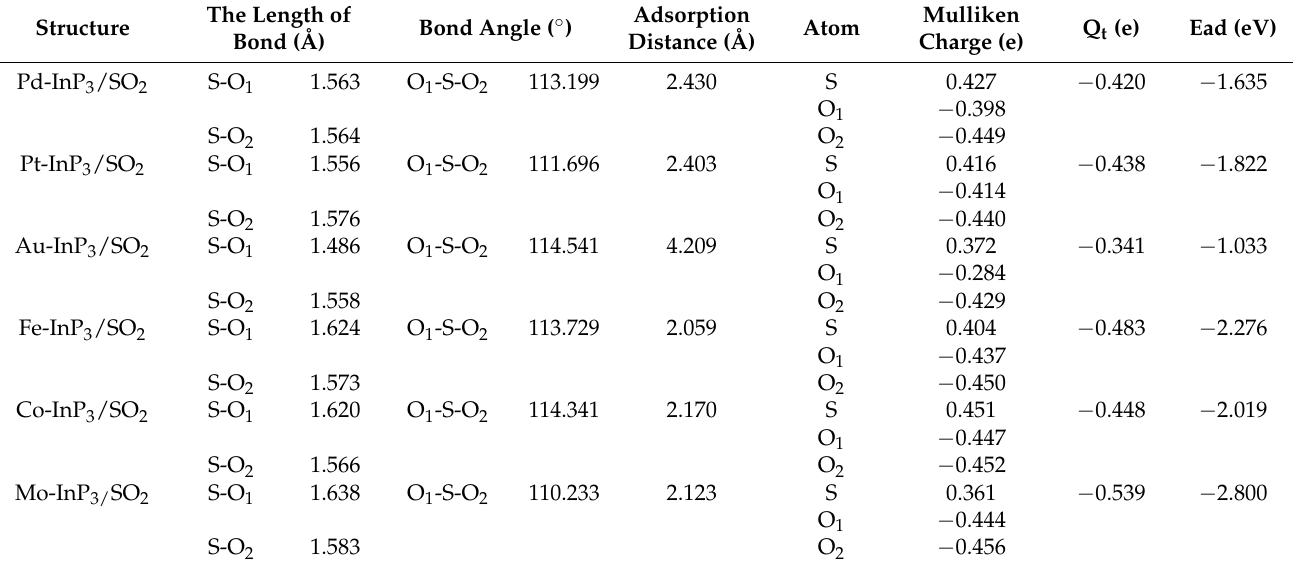
Table 2. Characteristic parameters of SO 2 adsorption on TM-InP 3 monolayers.